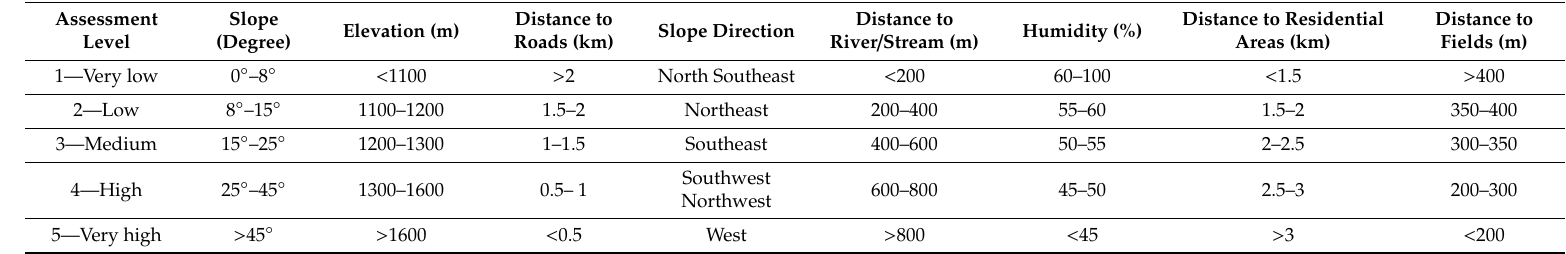
Table 2. Fire risk assessment for the forest information